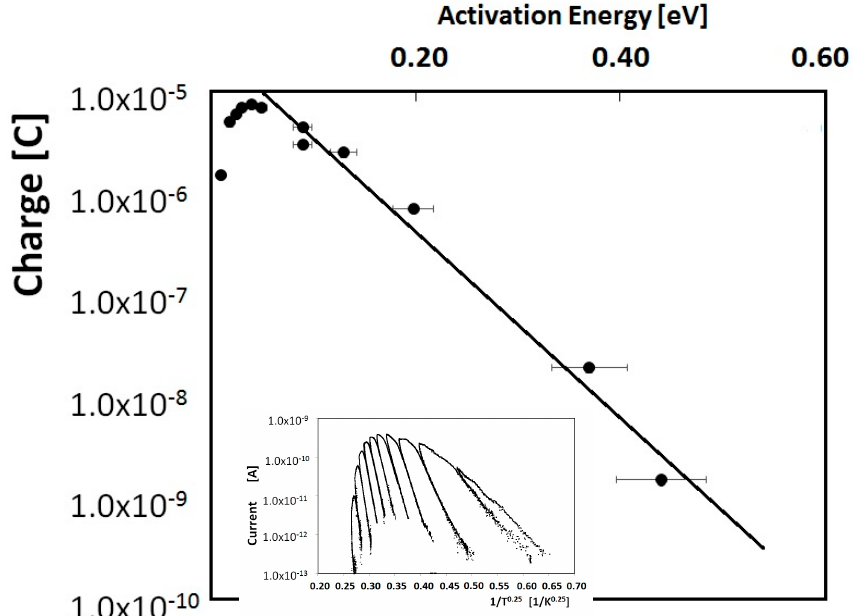
Figure 5. Emitted charge plotted as a function of the activation energy measured in the rising range of each peak of the fractionated TSC experiment shown in the inset. The exponential fit reflects the trend of the band tail in the deepest range within the forbidden gap. Inset: Delayed TSC in the range 5–150 K plotted as a function of 1/ T 1/4 to evidence the contribution of hopping conduction in the electrical transport.